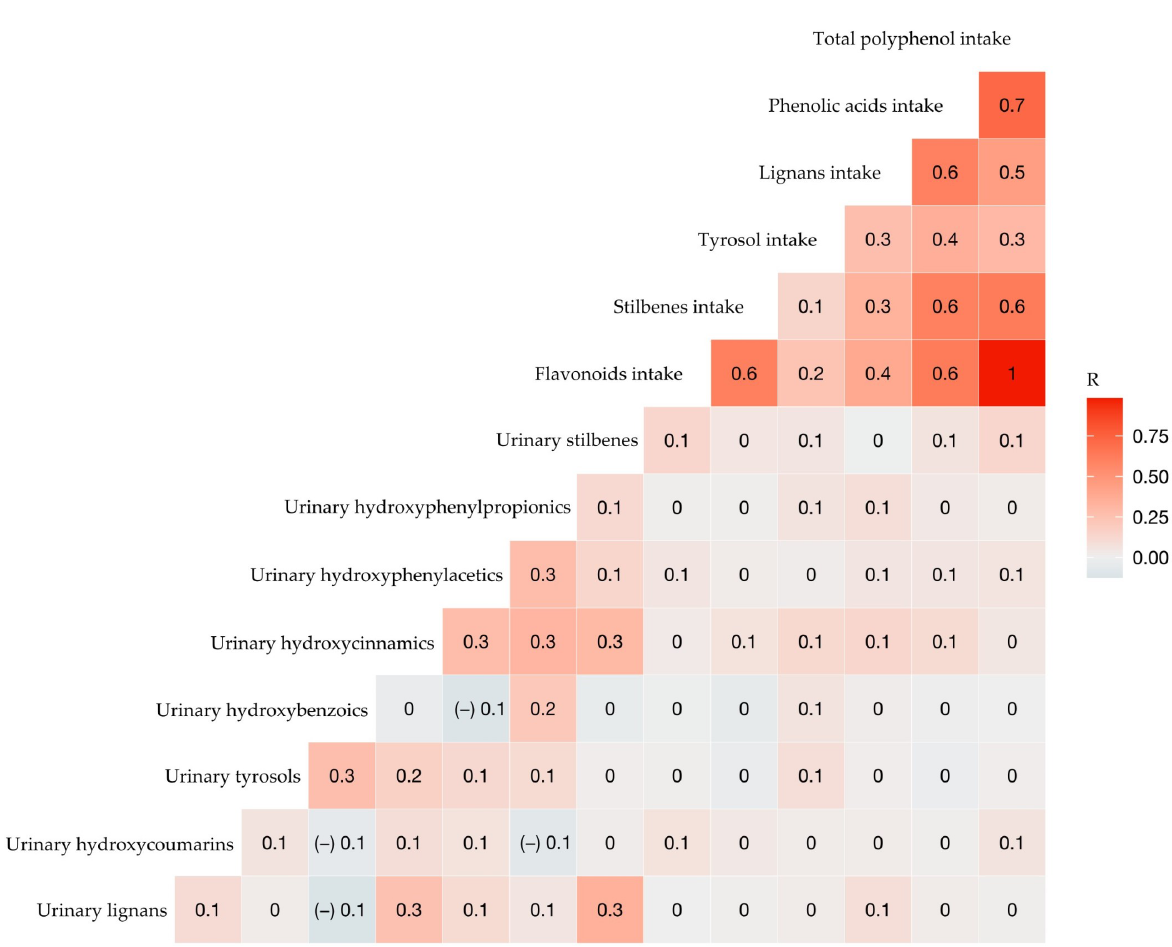
Figure S5: Heatmap of the Pearson correlation between subclass of microbial phenolic metabolites and polyphenol-rich food intake in adolescents. Table S1: Recovery obtained in Oasis HLB